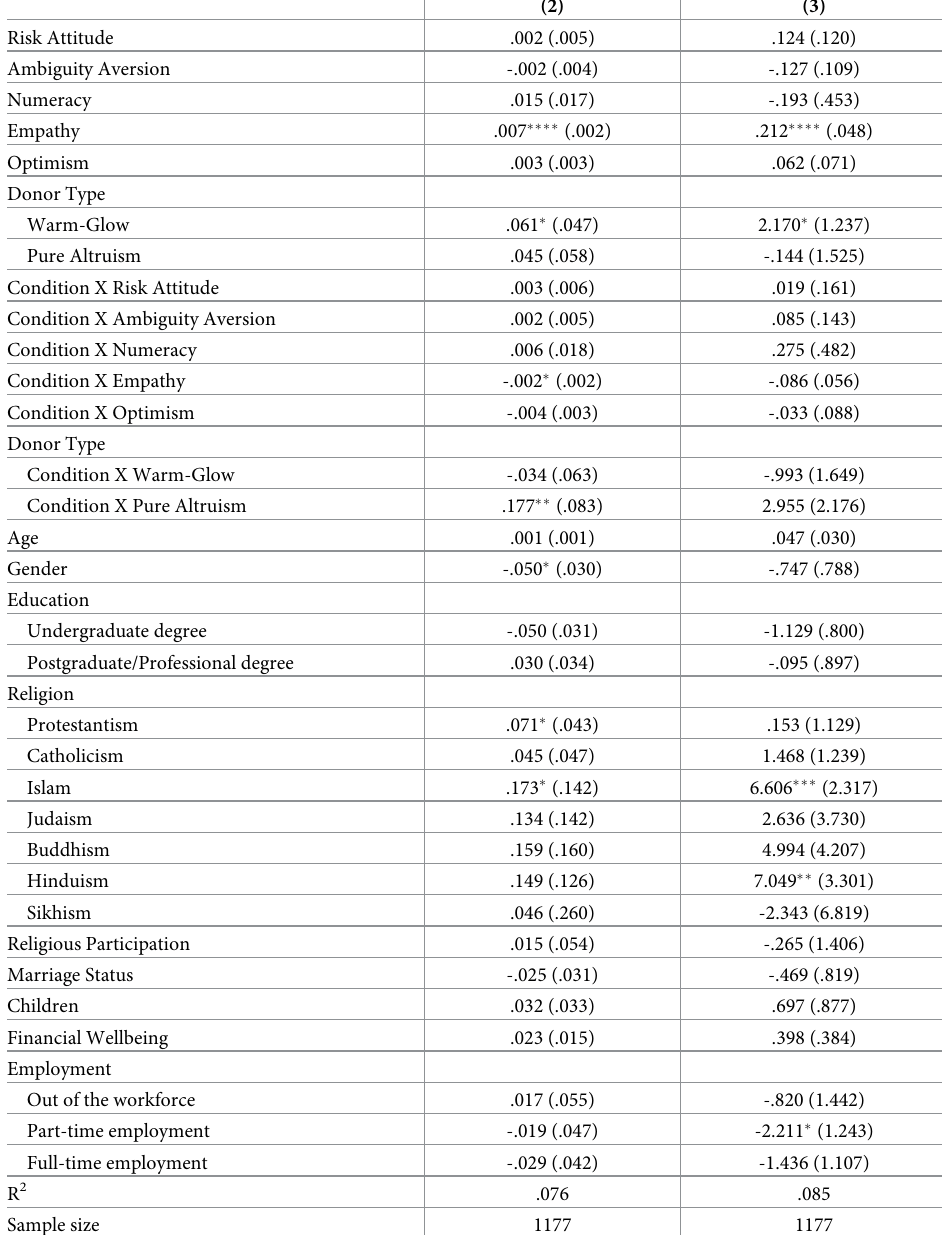
Table 4. Regression results for charitable giving behaviour in final choice predicting frequency of giving and size of